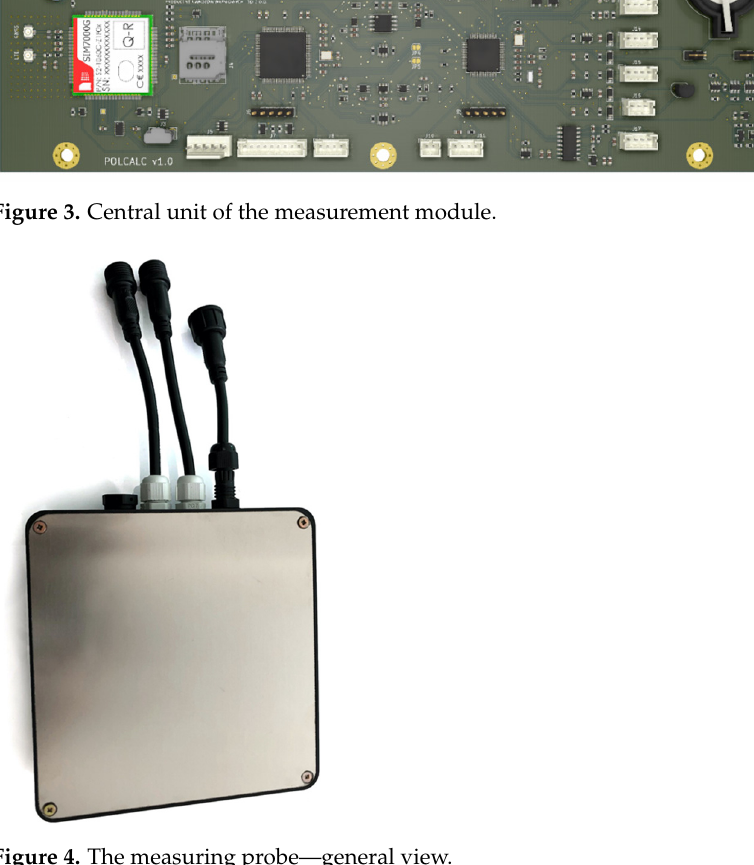
Figure 4. The measuring probe—general view.